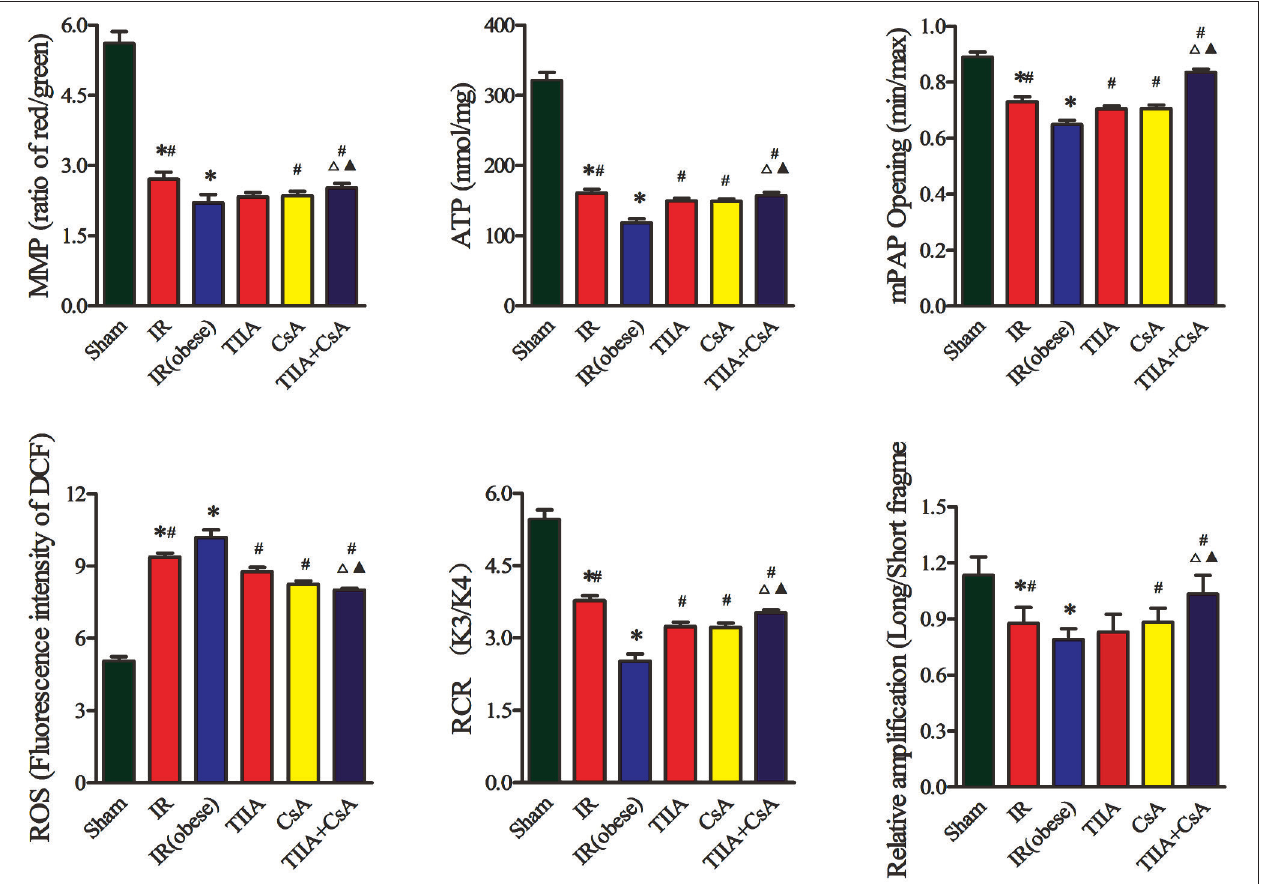
FIGURE 4 | Tanshinone IIA (TIIA) + cyclosporine A (CsA) preserved lung mitochondrial function in renal ischemia-reperfusion (IR)-induced lung injury. The MMP (ratio of red/green), the mitochondrial ATP, the opening of mPAP (%), the mitochondrial ROS, the mitochondrial RCR, and the mtDNA damage (ratio of long/short fragments) were recorded above. Rats were pretreated with TIIA alone or in combination with CsA followed by removing the right kidney and clamping of the left renal artery for 30min and reperfusion for 24h. Sham rats were used as control. * p < 0.05 vs. sham group, # p < 0.05 vs. IR (obese) group, 1 p < 0.05 vs. TIIA group, N p < 0.05 vs. CsA